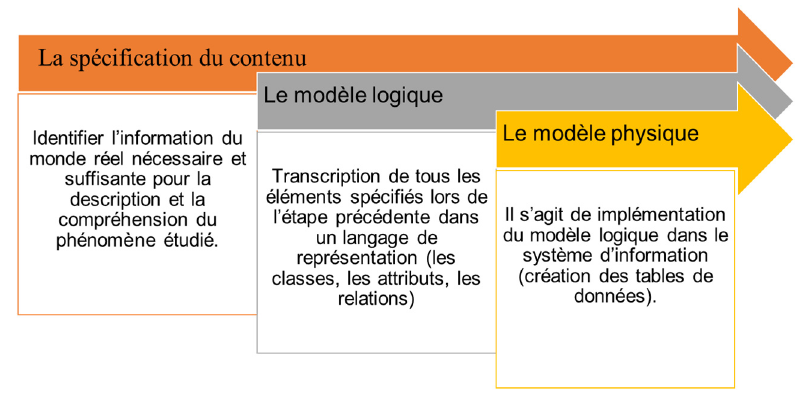
Figure 9. Of the phases to follow in the modelling of the data (Own elaboration from Rodier